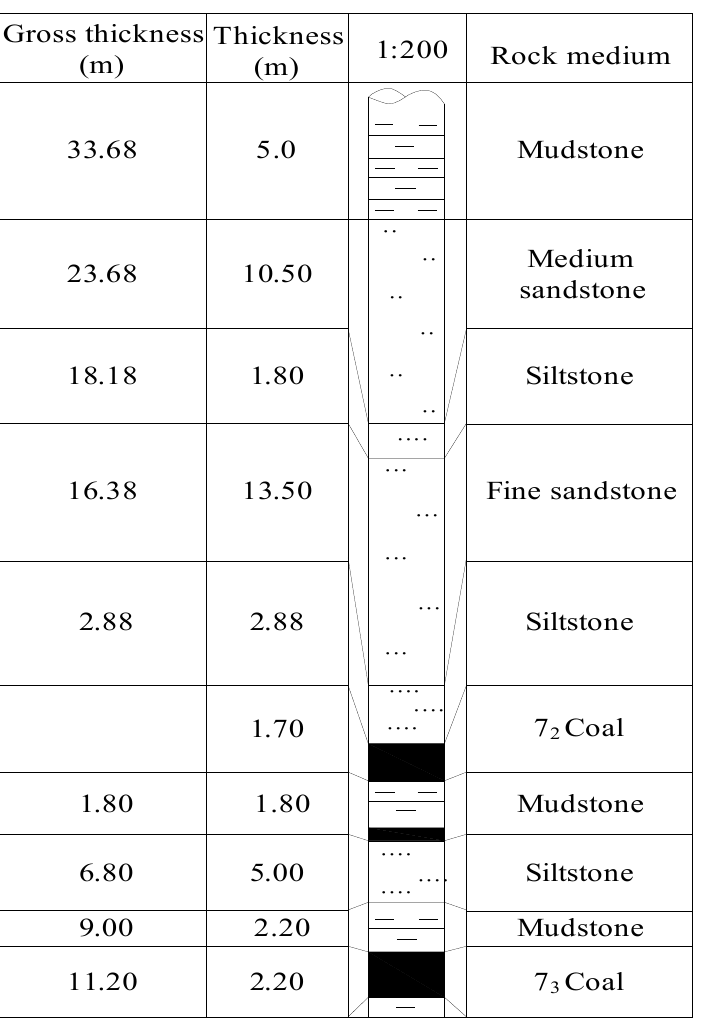
( b ) Blasting cartridge Figure 5. Experimental cartridge production system: ( a ) experimental detonator and ( b ) blasting cartridge. 3.2. Experimental Model Construction